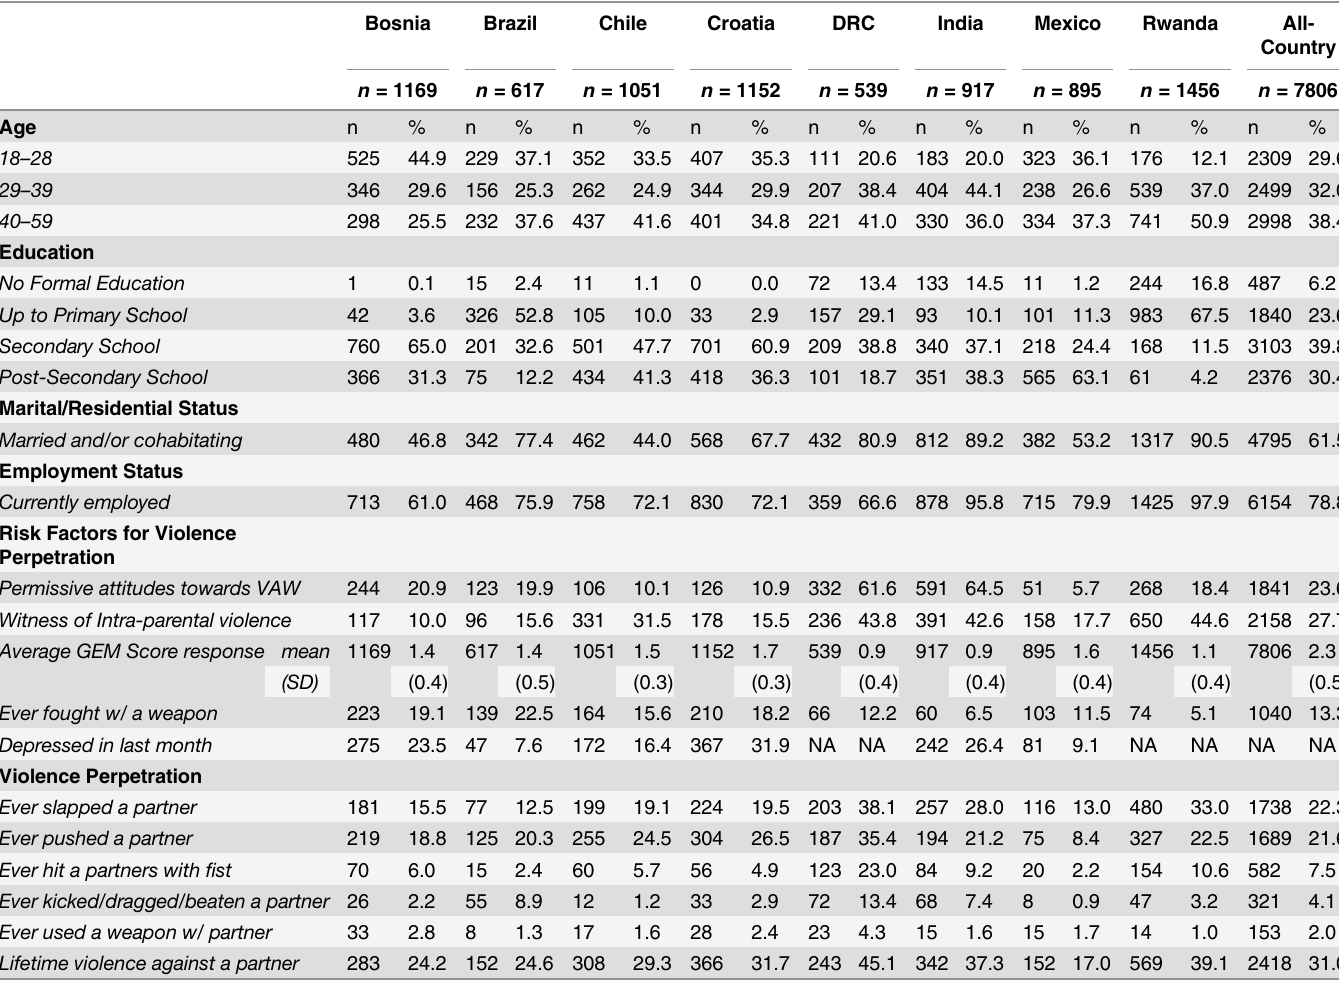
Table 2. Demographic and other characteristics of men in the International Men and Gender Equality Survey